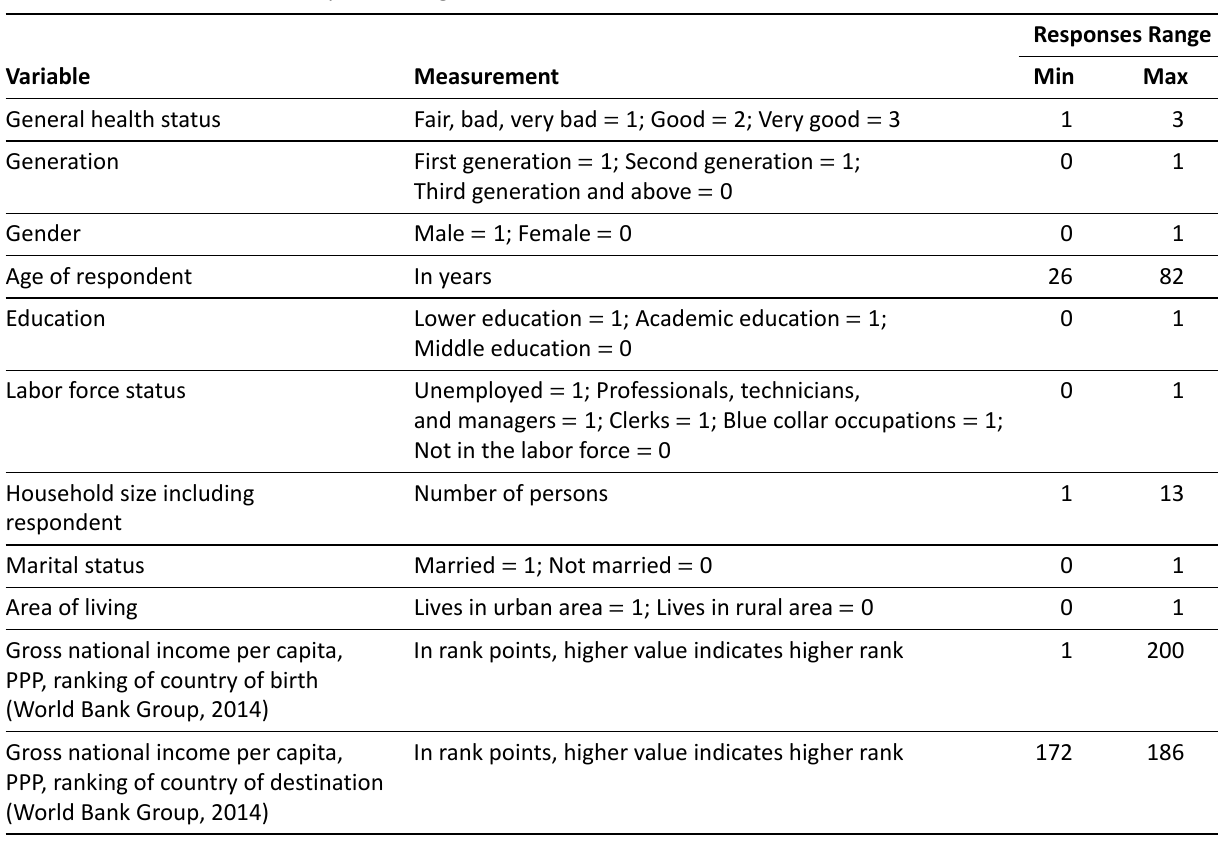
Table A1. Measurement and response categories of